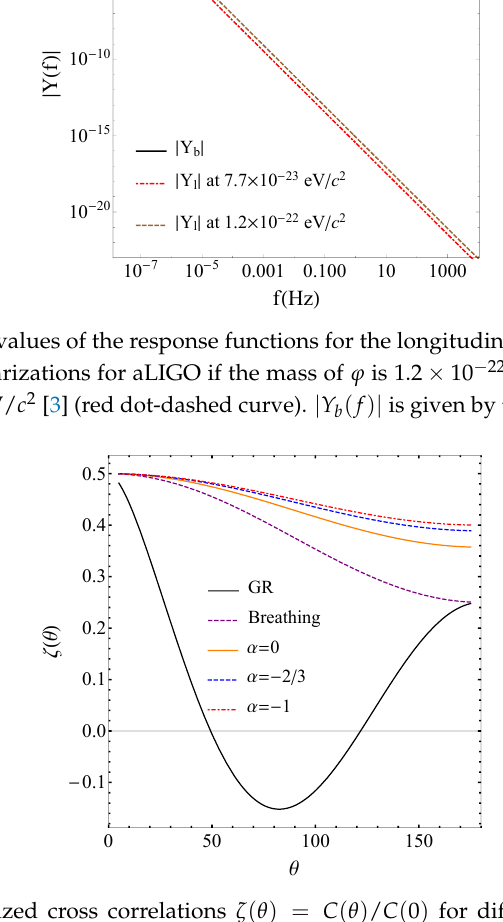
Figure 2. The normalized cross correlations ζ ( θ ) = C ( θ ) / C ( 0 ) for different polarization states. The black solid curve is for the plus and the cross modes, and so is labeled by “GR”. The purple dashed curve is for the massless scalar field, and so is labeled by “Breathing”. The remaining curves are for the massive scalar field with m = m b = 7.7 × 10 − 23 eV/ c 2 at different values of the power–law index α . It is assumed that the observation takes T = 5